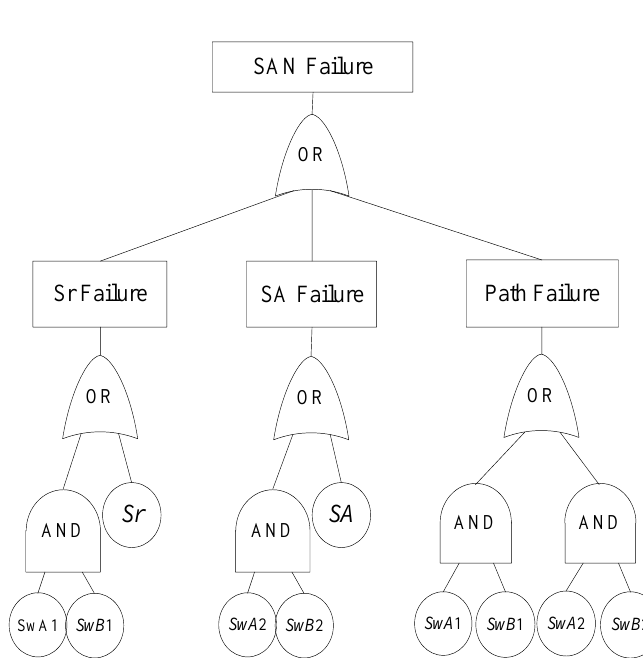
Figure 3. Equivalent FT model of the example mesh